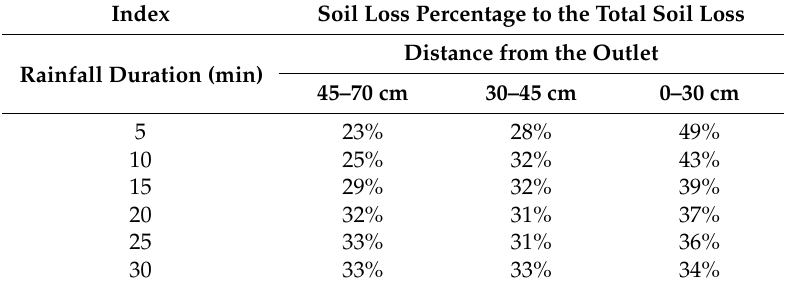
Table 3. Soil loss percentage of regions with different distances from the outlet: results of the erosion test with a 30 ◦